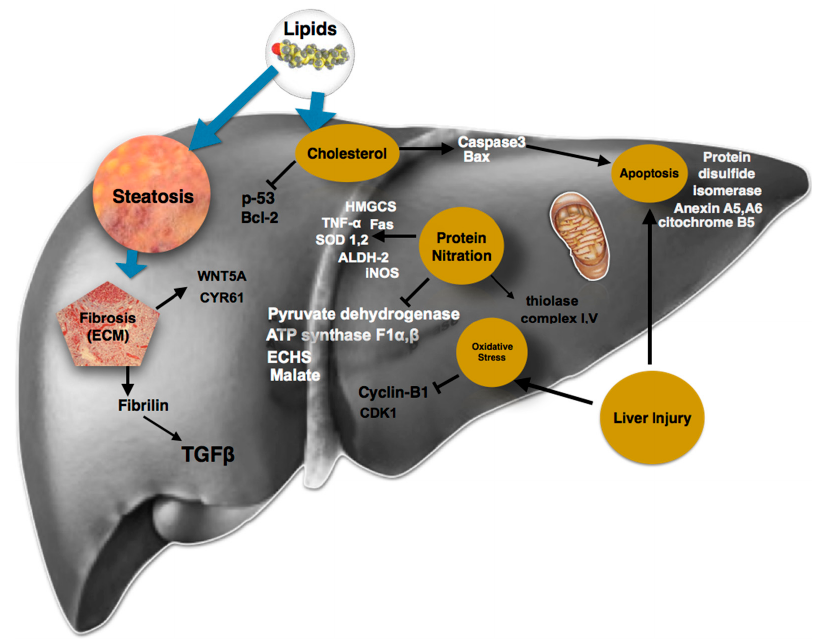
Figure 2. Activation and inhibition of different proteins in NAFLD.